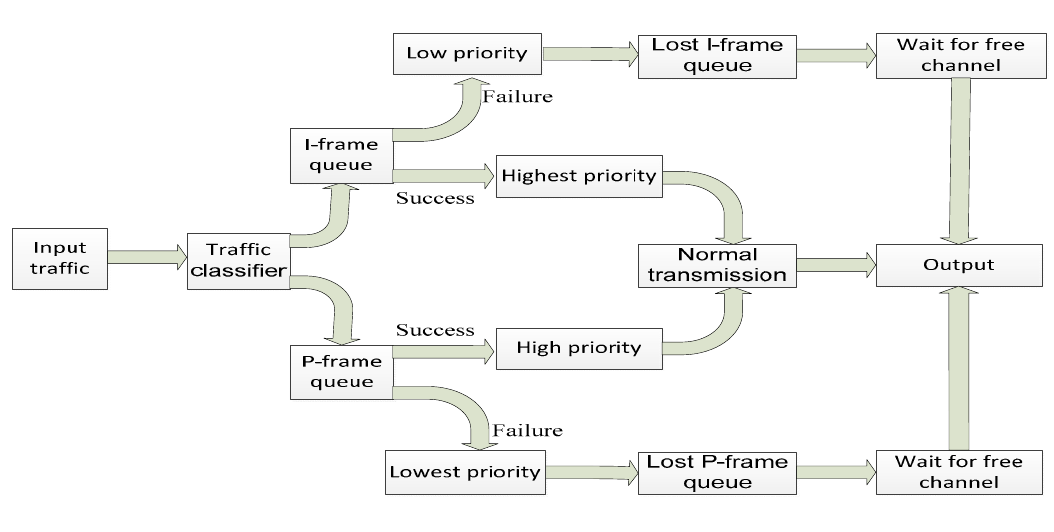
Figure 4. Queue schedular.